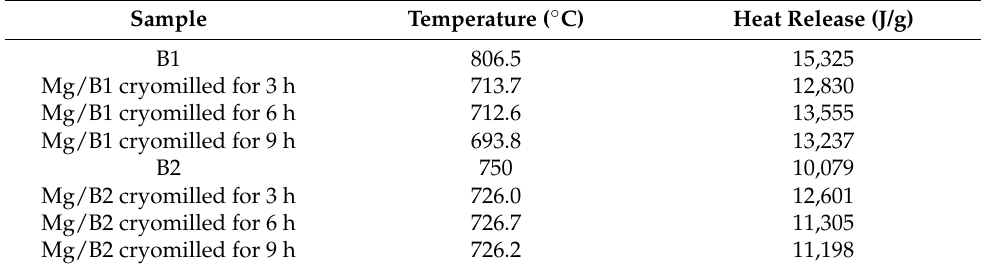
Table 4. The exothermic peak and released heat.